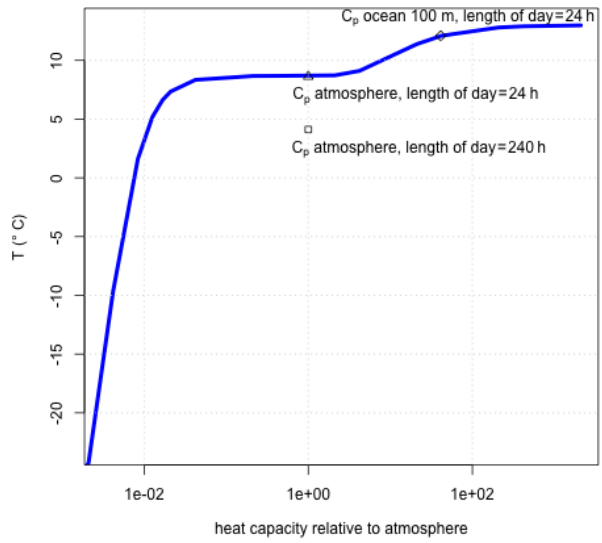
Figure 4. Temperature dependence on heat capacity (and rotation rate) when analyzing the daily mean temperature at 45 ◦ N using Eq.